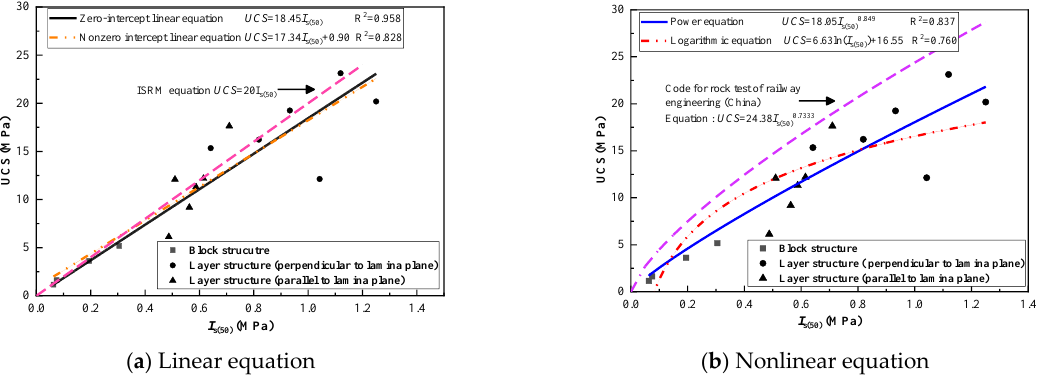
Figure 7. Fitting curves of the relationship between UCS and PLS: ( a ) Linear equation; ( b ) nonlin- ear